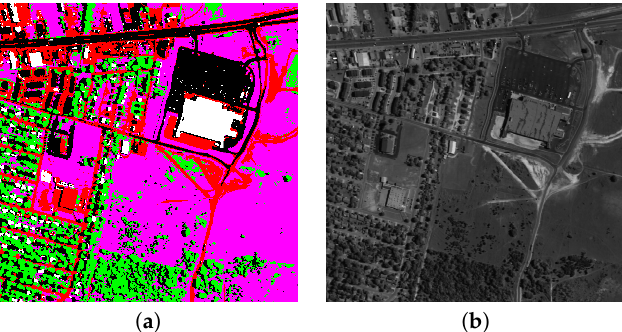
Figure 4. ( a ) Clustering of Urban and ( b ) its averaged band. Materials in Figure 4a: Asphalt (black), Roof (white), Grass (magenta), Tree (green), and Soil (red).